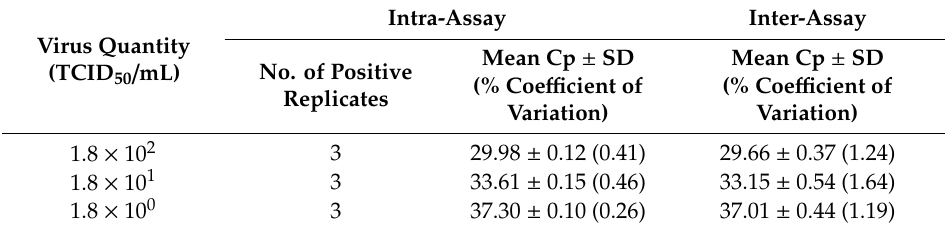
Table 3. Imprecision testing of the COVID-19-nsp2 assay using SARS-CoV-2 isolate